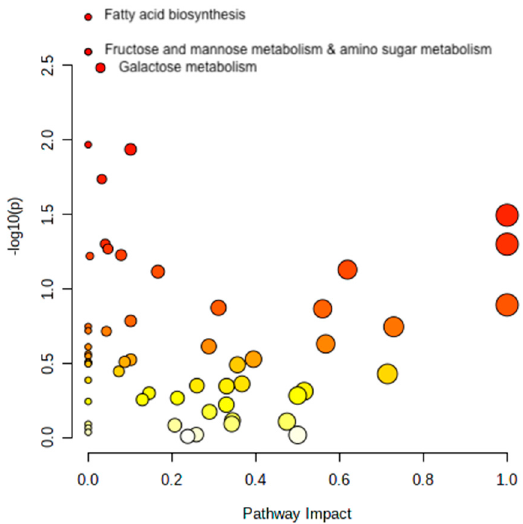
Figure 3. Pathway analysis. The figure shows the pathways that significantly differ in response to OGTT between controls and T2D subjects. Metabolites are arranged according to the scores based on enrichment analysis ( y -axis, Q -values) and topology analysis ( x -axis, arbitrary unit). The color of each circle shades from white to red according to the p -value, and the size is based on the pathway impact values. Only significant pathways are named in the figure. Figure created with Metaboanalyst 5.0.